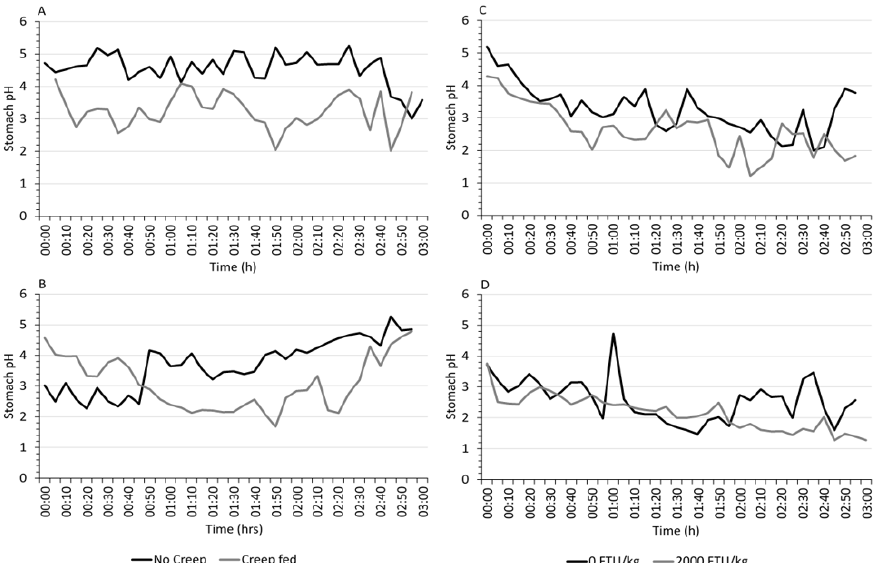
Figure 2. Effect of creep feed and phytase super-dosing on real-time stomach pH of piglets. Data show the average stomach pH readings taken over 3 h from eight pigs per treatment (creep/no creep) at 7 days pre-weaning ( A ), from seven pigs per treatment (creep/no creep) at day of weaning ( B ), from six (0 FTU/kg phytase) and eight (2000 FTU/kg phytase) pigs per treatment at day 7 ( C ) and eight pigs per treatment (0 or 2000 FTU/kg) at day 21 ( D ) post-weaning. Table 3. Real-time stomach pH of piglets in response to creep feed during suckling and at weaning.